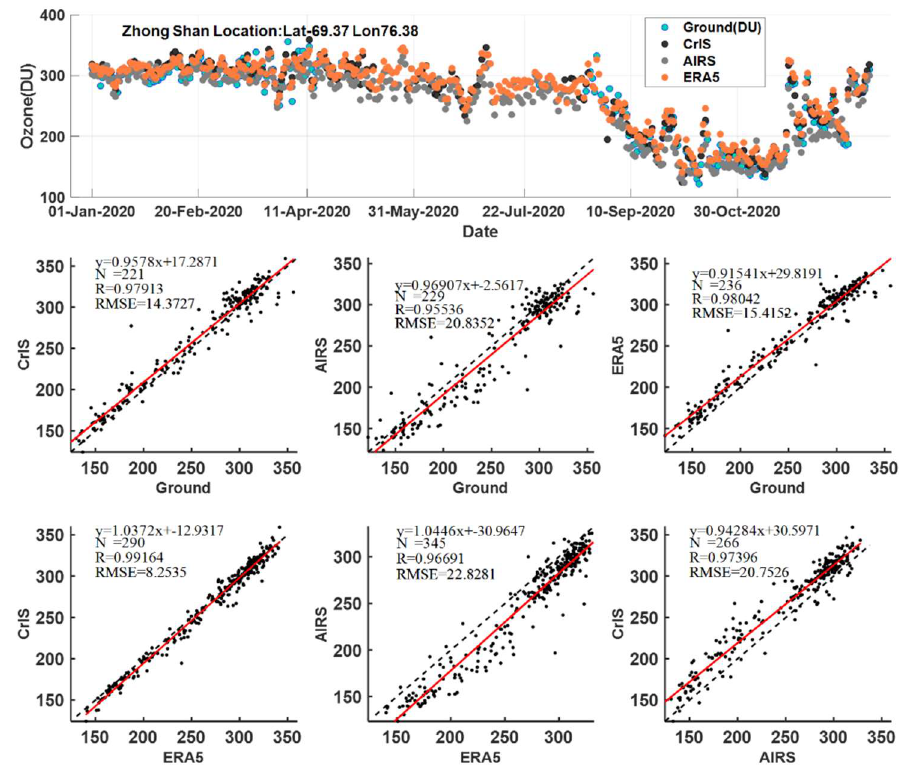
Figure 6. Same as Figure 4. but for Zhongshan site.